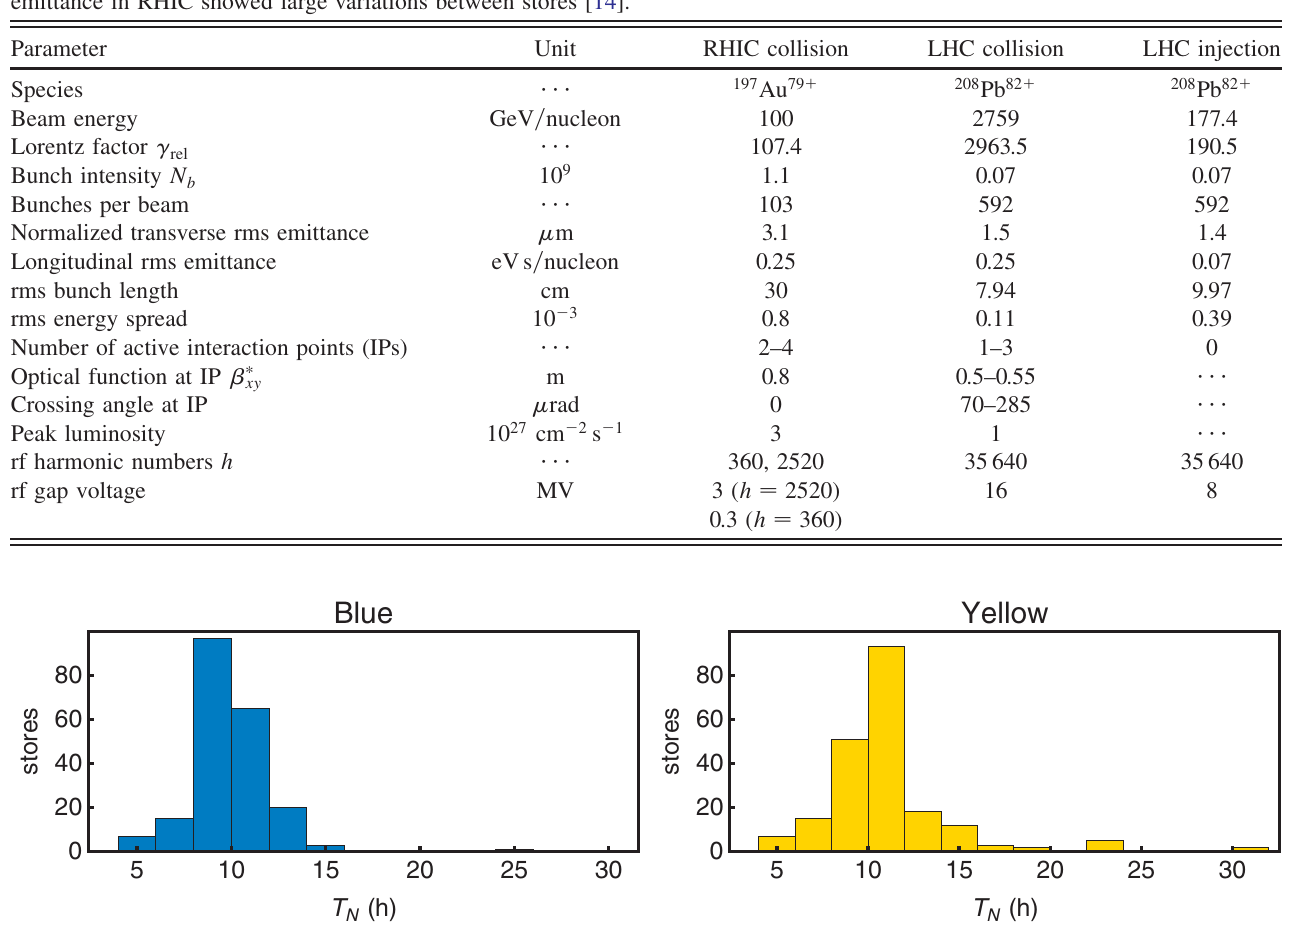
FIG. 1. (Color) Blue and Yellow beam lifetimes T N obtained by fitting Eq. (1) to measurements. Only stores without stochastic cooling are